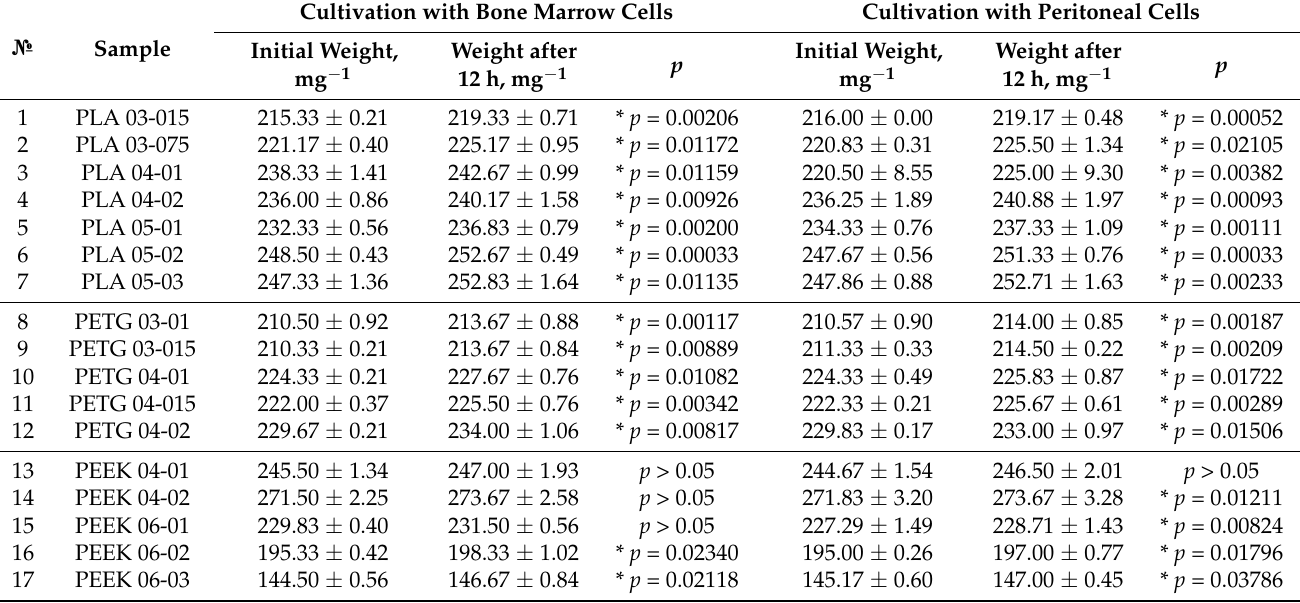
Table 3. Weight of polymer samples, initial and after 12-h cultivation with